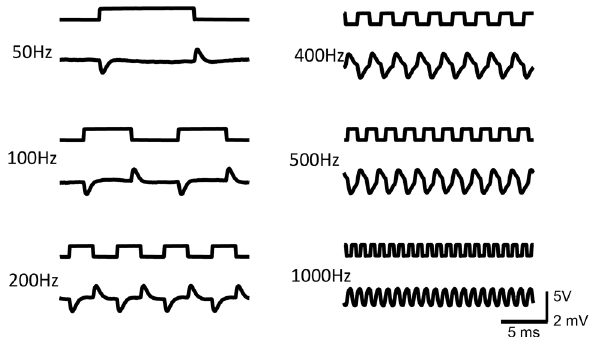
Figure 2. Input voltage to the coil and the magnetically induced electric potential. Upper traces: Square waves (10 V) of various frequencies were generated by a signal generator and were delivered to the miniature coil via a power amplifier. Lower traces: Magnetically induced electric potential recorded in the petri dish.